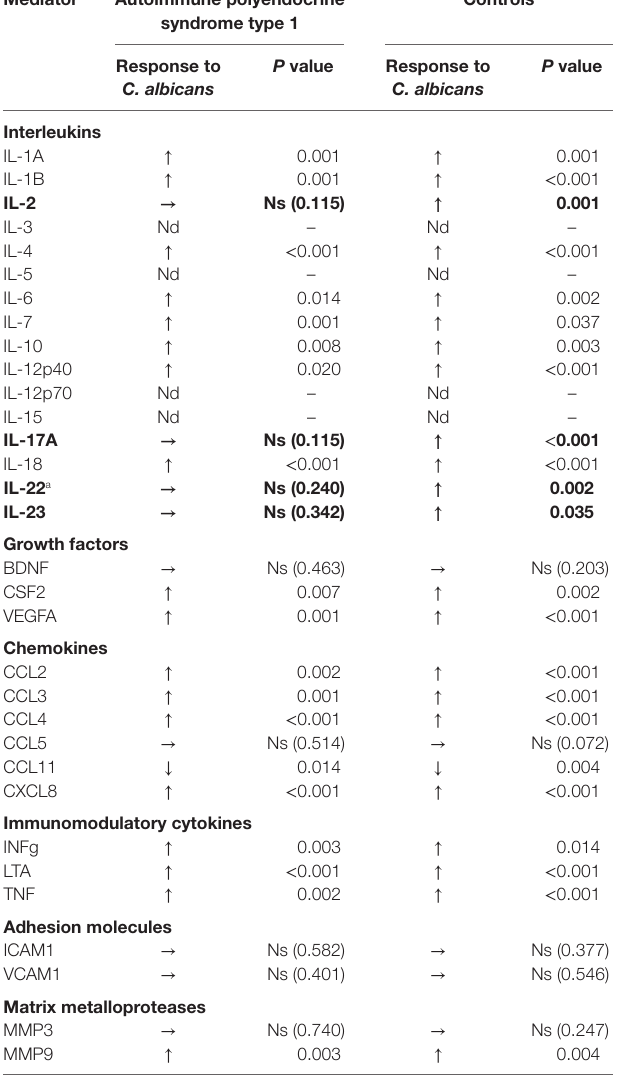
Table 2 | Change of different immune mediators in response to Candida albicans in patients and